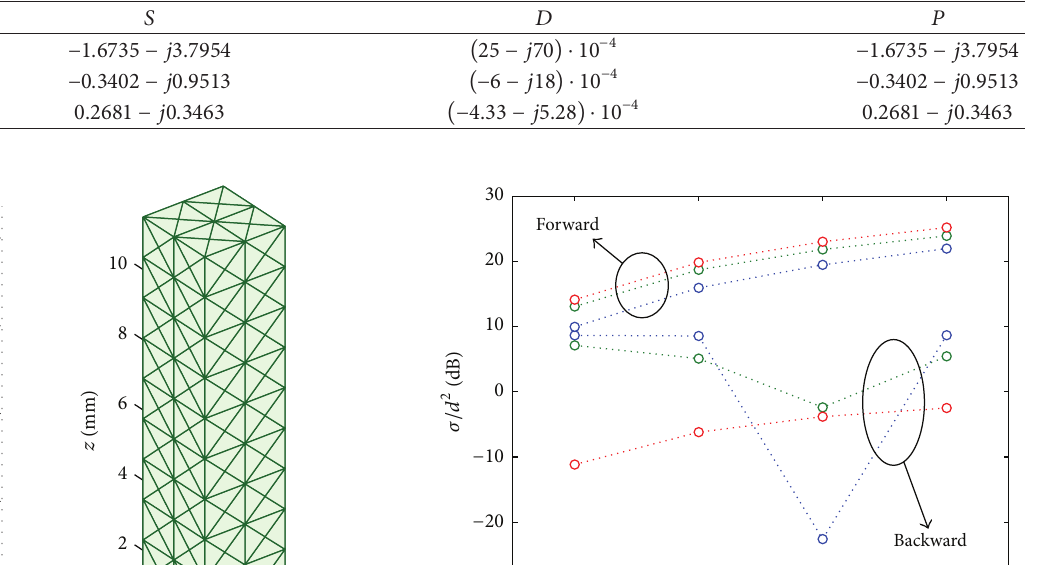
Table 1: Plasma parameters for the problem of Figures 8, 9, and 10.